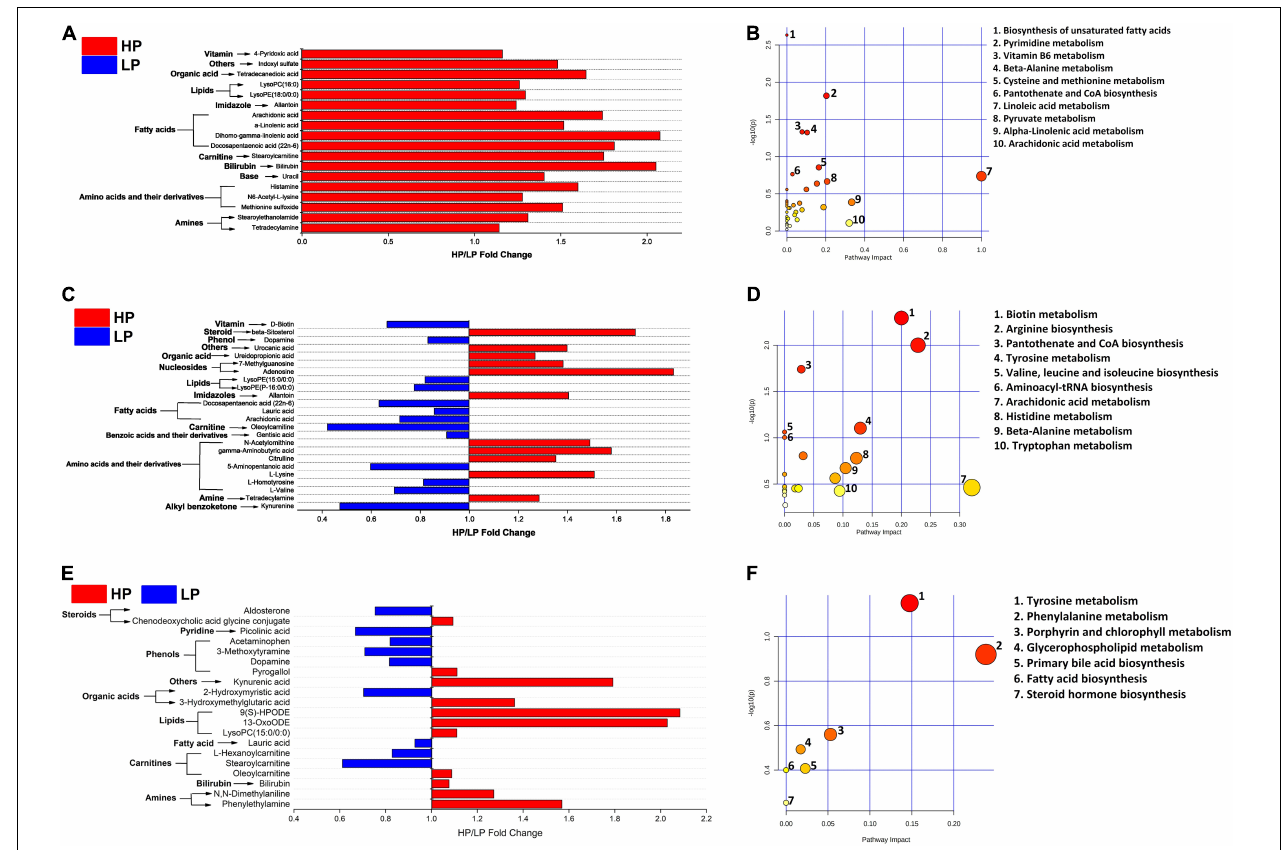
FIGURE 5 | (A) Fold change (HP/LP) of significantly different (VIP > 1, FDR < 0.05) serum metabolites between the HP and LP cows. (B) The metabolic pathway impacted by serum metabolites in the HP and LP cows. (C) Fold change (HP/LP) of significantly different (VIP > 1, P < 0.05) milk metabolites between HP and LP cows. (D) The metabolic pathway impacted by milk metabolites in the HP and LP cows. (E) Fold change (HP/LP) of significantly different (VIP > 1, P < 0.05) rumen metabolites between the HP and LP cows. (F) The metabolic pathway impacted the rumen metabolites between the HP and LP cows. In the metabolic